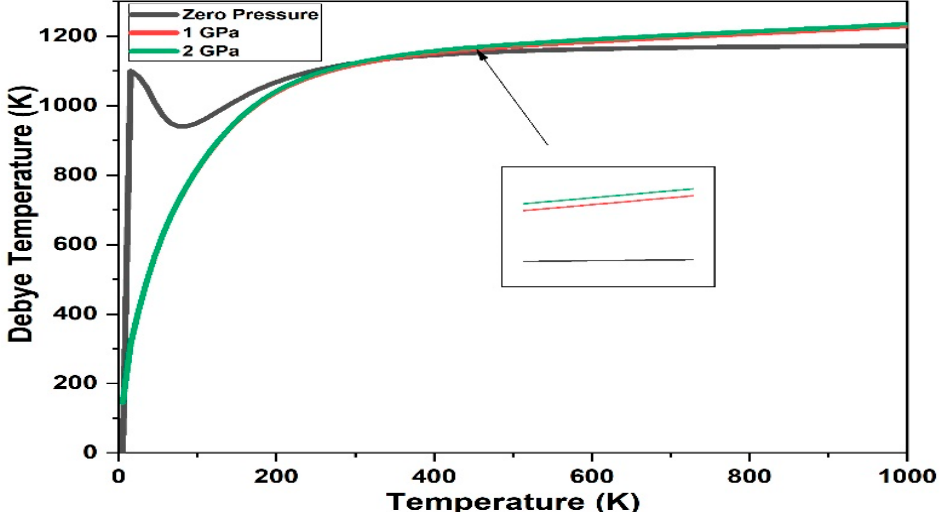
Figure 12. Debye temperature